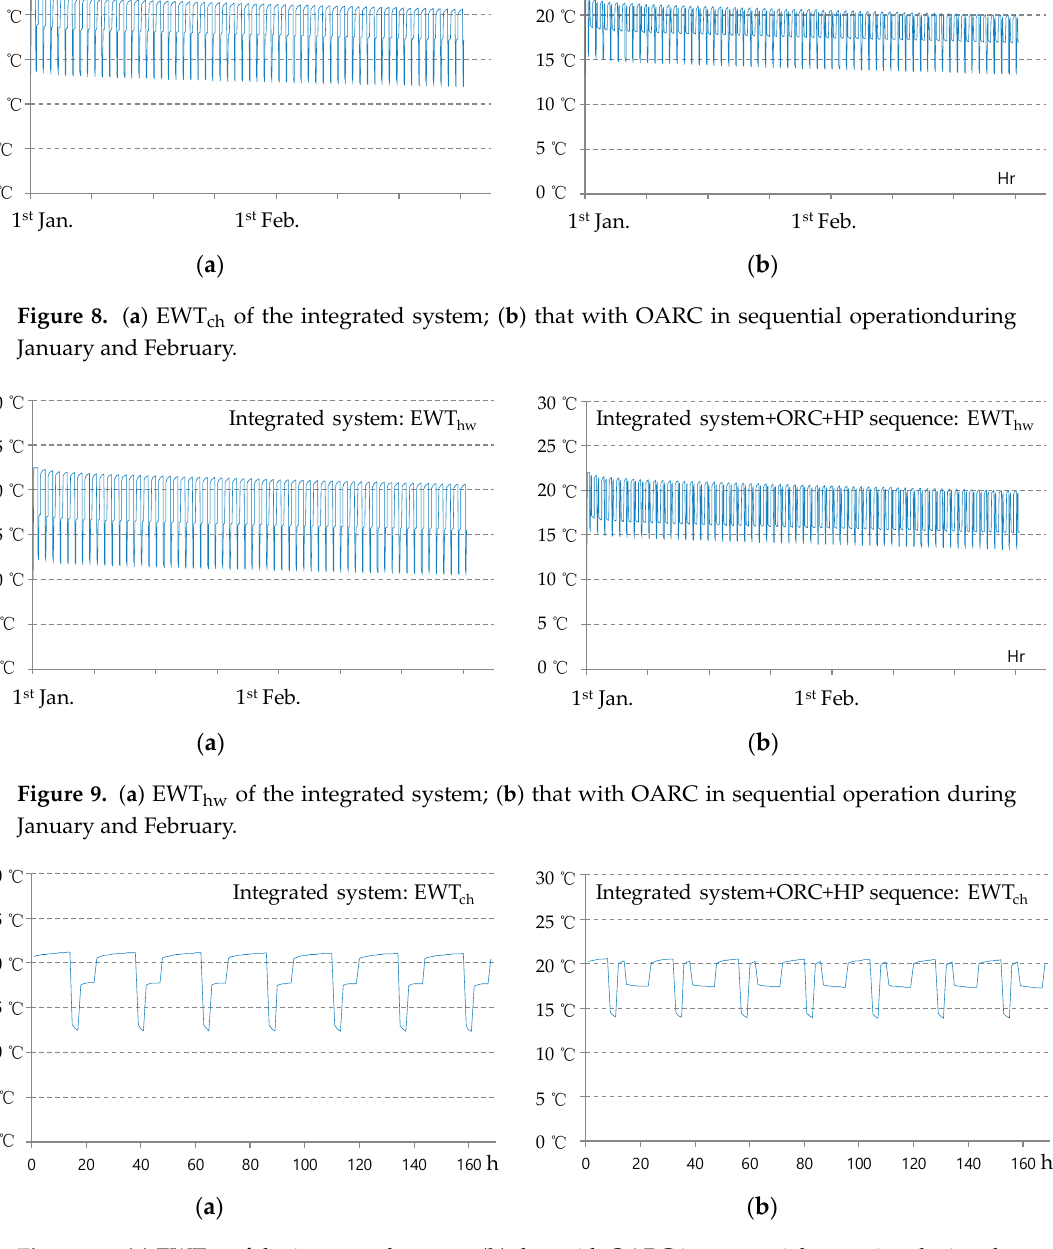
Figure 10. ( a ) EWT ch of the integrated system; ( b ) that with OARC in sequential operation during the first week of February.